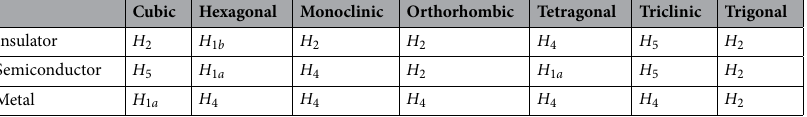
Table 5. The Classic Calculator considering crystal system and bandgap simultaneously (CLA 1 ). Bandgap ( (cid:31) E ) was calculated theoretically. Materials are classified as insulators ( � E > 2 eV ), semiconductors ( � E < 2 eV ) and metals ( (cid:31) E = 0